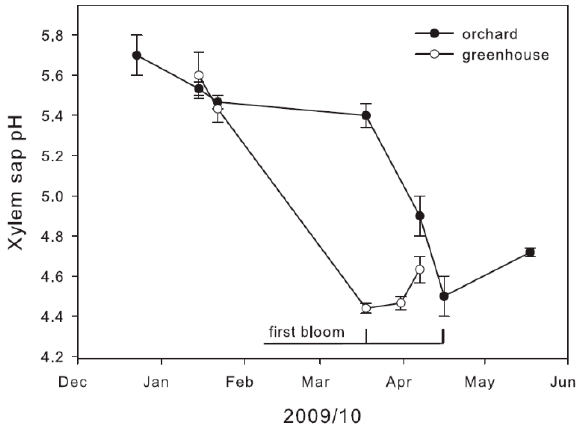
Figure 2. Seasonal change of pHx of twigs of potted M. domestica trees grown in an orchard (closed circles) or under greenhouse conditions (10/25 °C; open circles). Data are mean values ± SE (n = 4). Trees were transferred into the greenhouse on 15 January 2010.